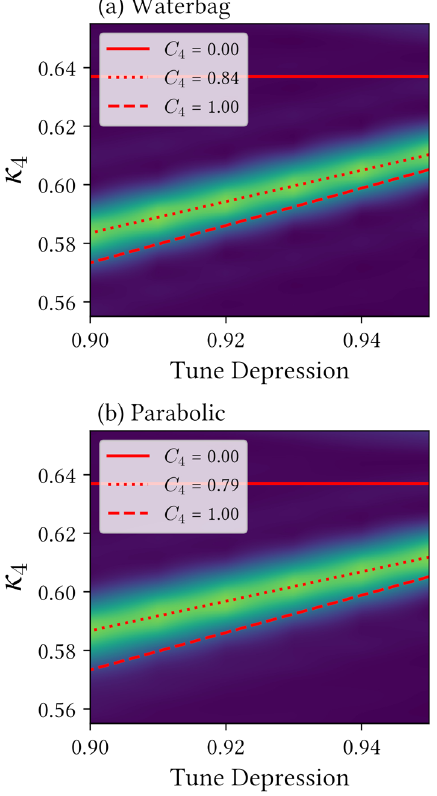
FIG. 17. Emittance growth chart of the sum resonance with ð k; l Þ ¼ ð 3 ; 1 Þ excited by the octupole driving perturbation. The perturbation amplitude assumed in these W ARP simulations is 1% of the focusing field ’ s. The dotted line is the location of the stop- band peak fitted by Eq. (15) with C 4 ¼ 0 . 84 for waterbag, and C ¼ 0 . 79 for parabolic. The color bar omitted here is the same as 4 employed in Figs. 15 and 16.